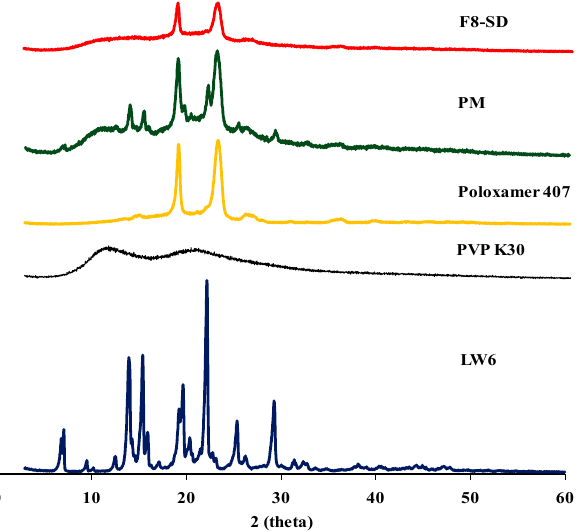
Figure 8. X-ray powder diffraction (XRPD) diffractograms of LW6, polymeric carriers, PM, and F8-SD.